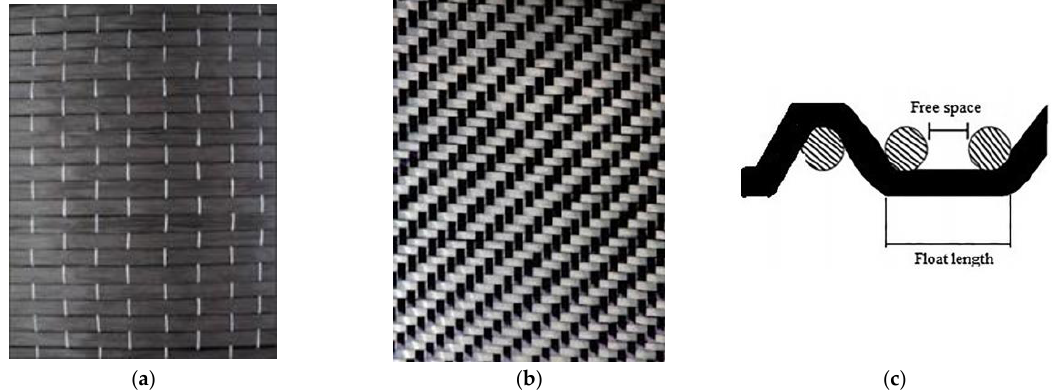
Figure 1. Carbon fiber fabric: ( a ) Unidimensional; ( b ) two dimensional twill; ( c ) weaving of the twill pattern.